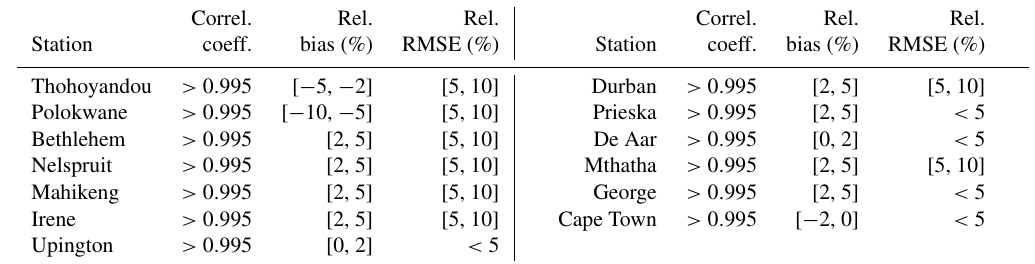
several climates: tropical climates of monsoon (Am) and sa- vannah (Aw) types, arid and hot or cold climates of steppe